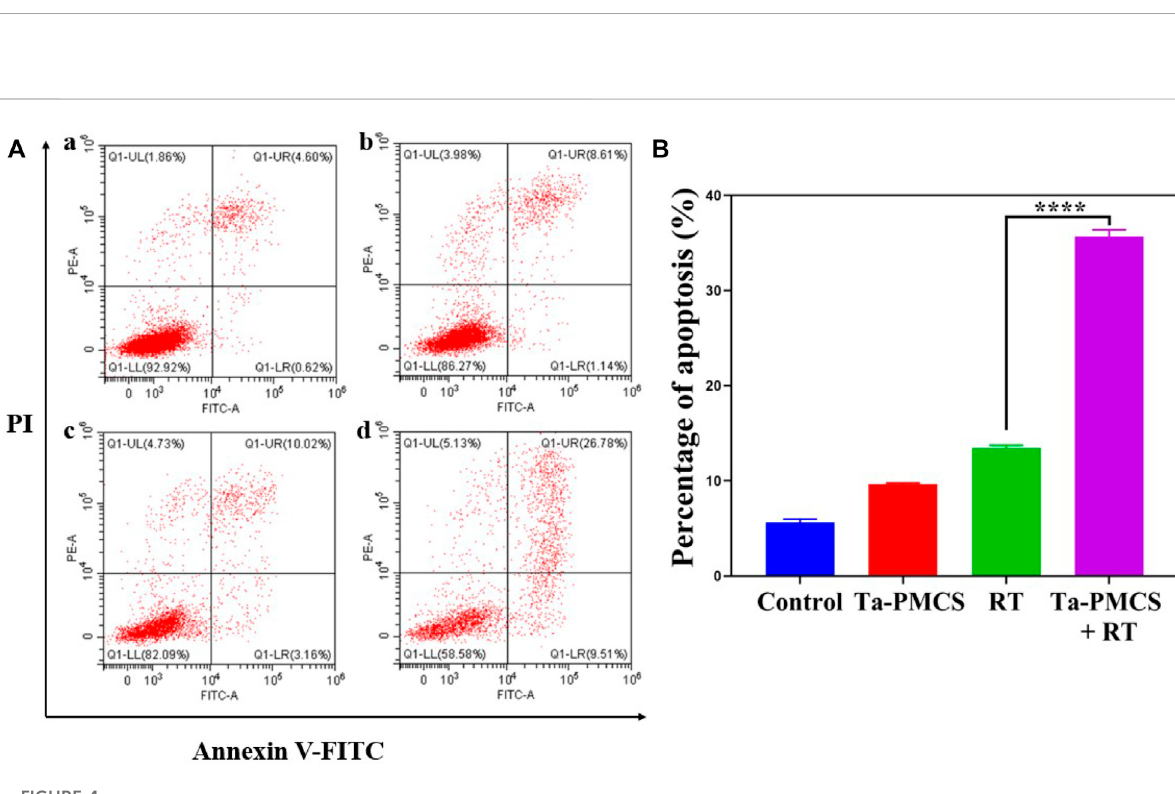
AnnexinV-FITC/PIdual-stainingwasusedtoassesstheapoptosisratesofHeLacells. (A) Control; (B) Ta-PMSC(20 ug/mL); (C) RT(6 gy); (D) Ta- PMSC (20 ug/mL) + RT (6 gy). * p < 0.05, ** p < 0.01, *** p <